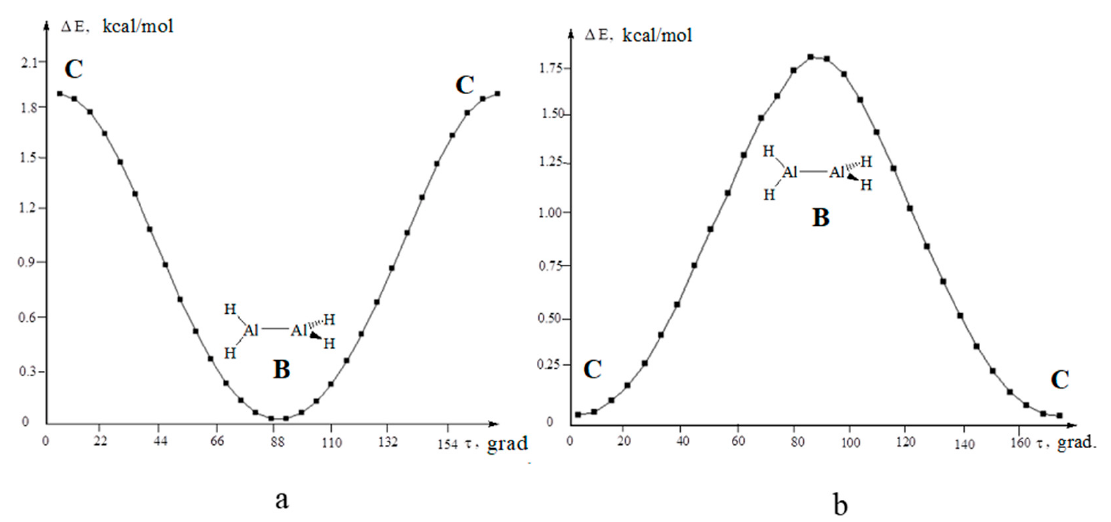
Figure 9. Forms of dialane, Al 2 H 4 . Adapted with modification [178].